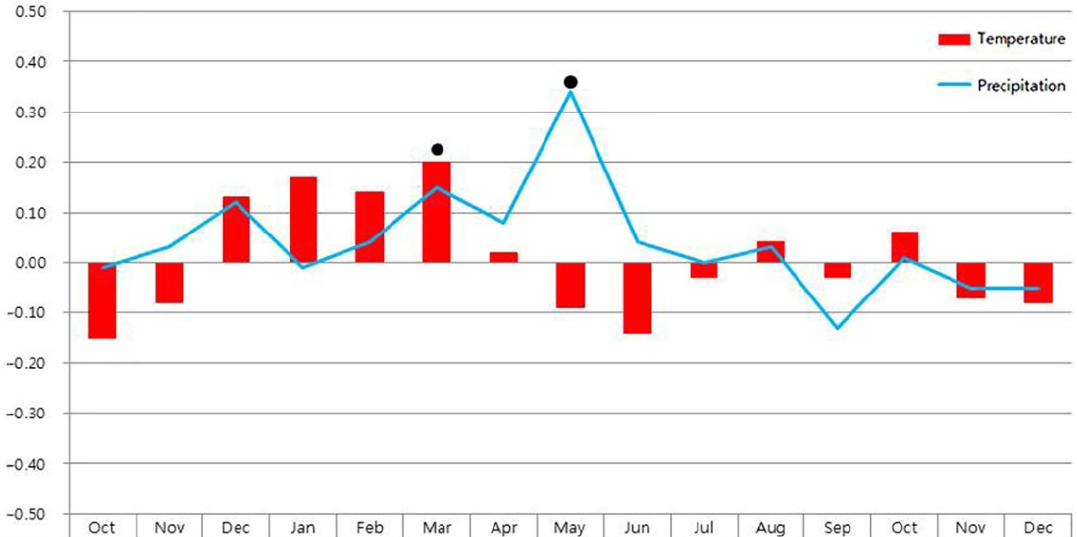
Figure 7. The correlation between climate data and tree-ring chronology of P. densiflora from Mt. Worak (significant